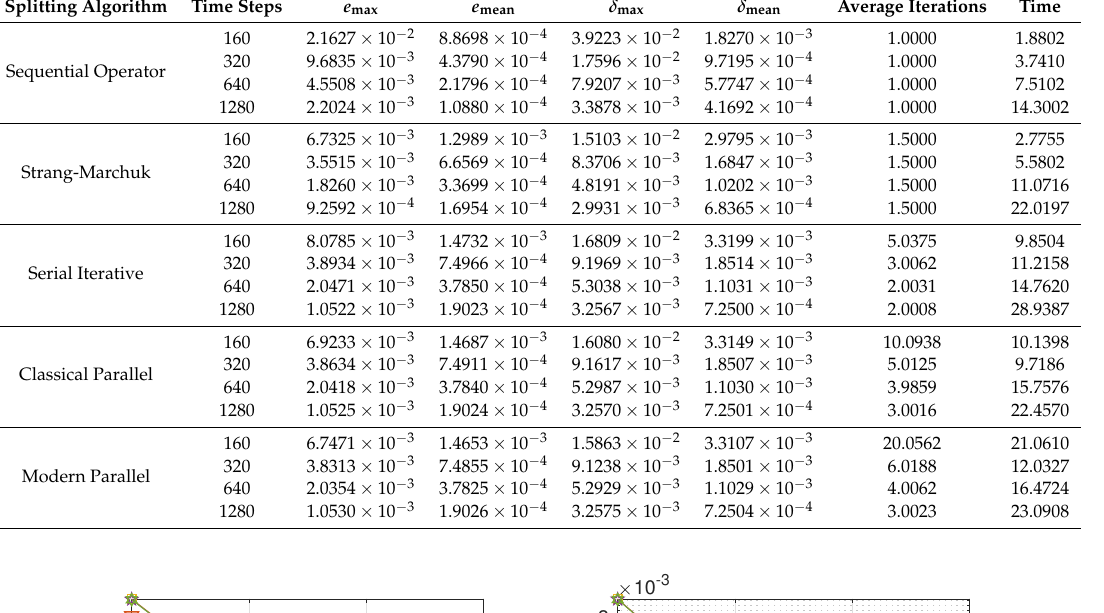
Table 11. Mixed convection-diffusion and Burgers’ equation. Results of the directional decomposition with 10 spatial subintervals and different number of temporal steps.